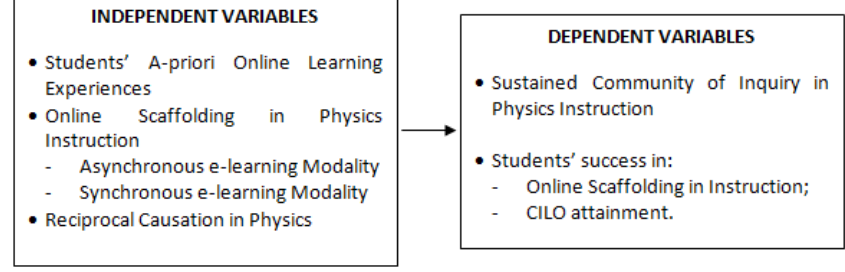
Figure 1. Research